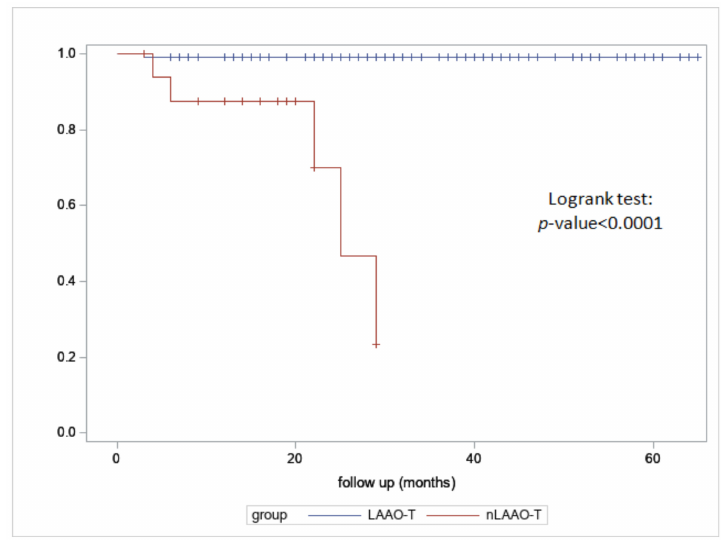
Figure 5. Kaplan–Meier for hemorrhage for LAAOT and